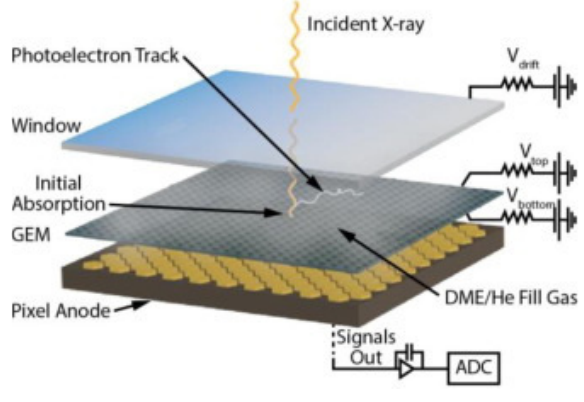
Figure 4. The GPD polarimeter concept design.